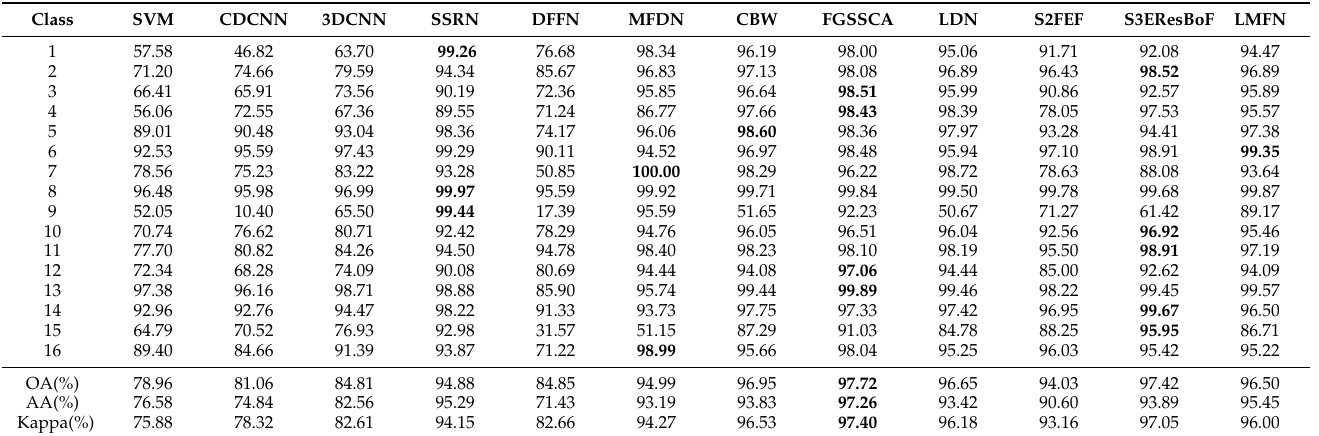
Table 6. Performance comparison with state-of-the-art methods, in terms of classification accuracy, for the IN data set. The best results are highlighted in bold font.